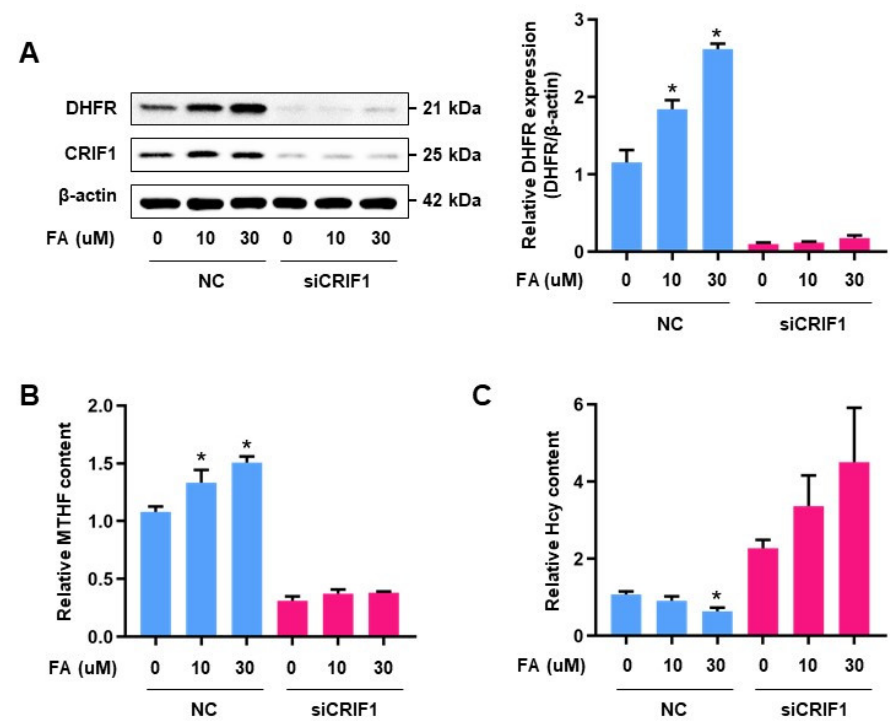
Figure 2. The effect of CRIF1 deficiency on FA-induced homocysteine and folate intermediates regulation: ( A ) DHFR protein level in HUVECS with 10 µ M and 30 µ M of FA after NC or CRIF1 siRNA treatments. Graph shows the densitometric assay of band intensity. ( B ) Fluorescent-HPLC analysis of MTHF content using the peak area of CRIF1-deleted HUVECs before FA treatments. ( C ) Relative quantification of the Hcy level with NC or siCRIF1 siRNA with/without FA. Data are presented with three independent experiments as the mean ± SEM. * p < 0.05 versus NC-treated cells with 0 µ M FA in the NC group.